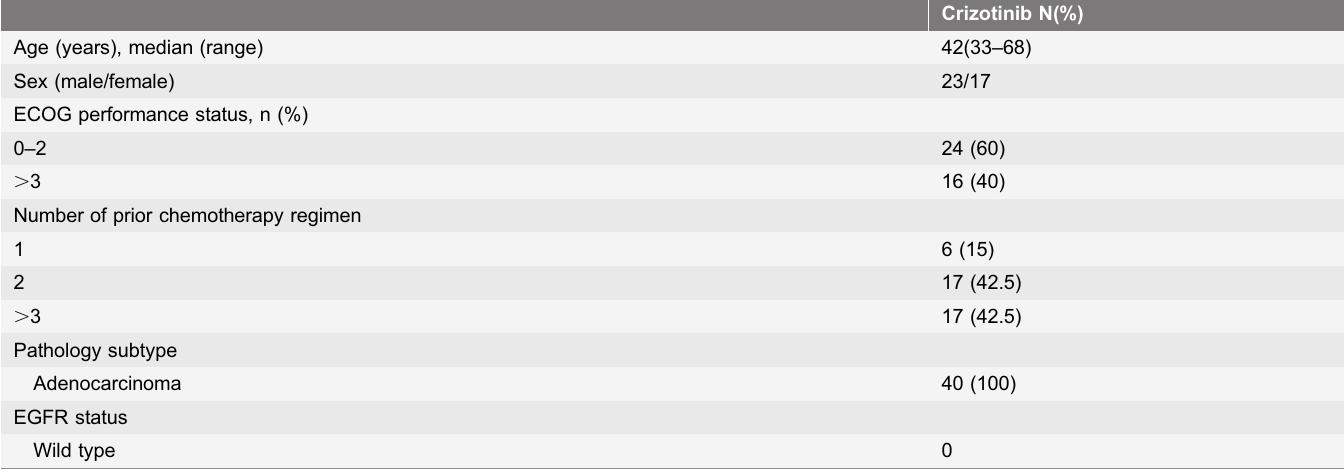
Table 1. Baseline demographics of 40 Chinese patients treated with crizotinib.